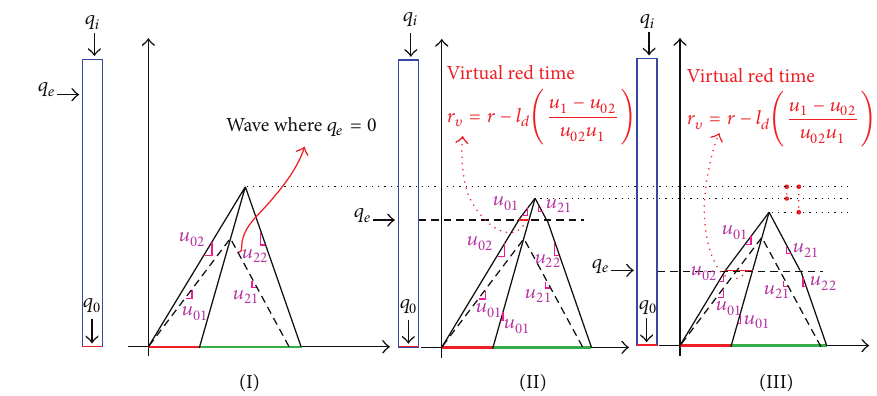
Figure 20: Stopping wave and starting wave with endogenous flow.